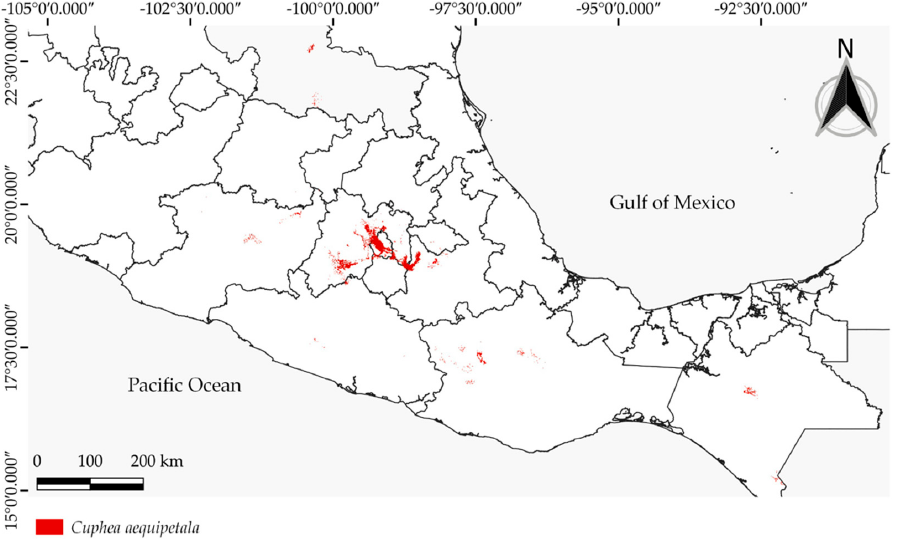
Figure 2. Potential distribution of Cuphea aequipetala Cav. in Mexico using a maximum entropy model. The red color indicates the polygons with the highest probability of presence (0.74–1.0). The analysis of the potential distribution of C. aequipetala Cav. indicated a high pre- dictive performance value (AUC) of 0.98 (Figure 3a). The response curves of the variables that contributed most to the suitability of the habitat for C. aequipetala Cav. are illustrated in Figure 3b–d. With respect to altitude (Figure 3b), it was observed that the maximum value of AUC (0.81) corresponded to an altitude of 3100 m above sea level. Regarding the precipitation in the driest month (Figure 3c), the greatest probability of presence (AUC of 0.62) corresponded to precipitation of 9 mm. On the other hand, the highest AUC value of the mean temperature in the driest quarter (Figure 3d) was 0.69, which corresponds to a temperature of 9.5 °C.